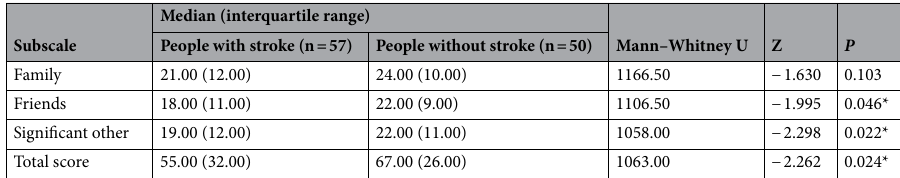
Table 5. Comparisons of MSPSS-C subscales and total score between the people with stroke and without stroke. p < 0.05*.